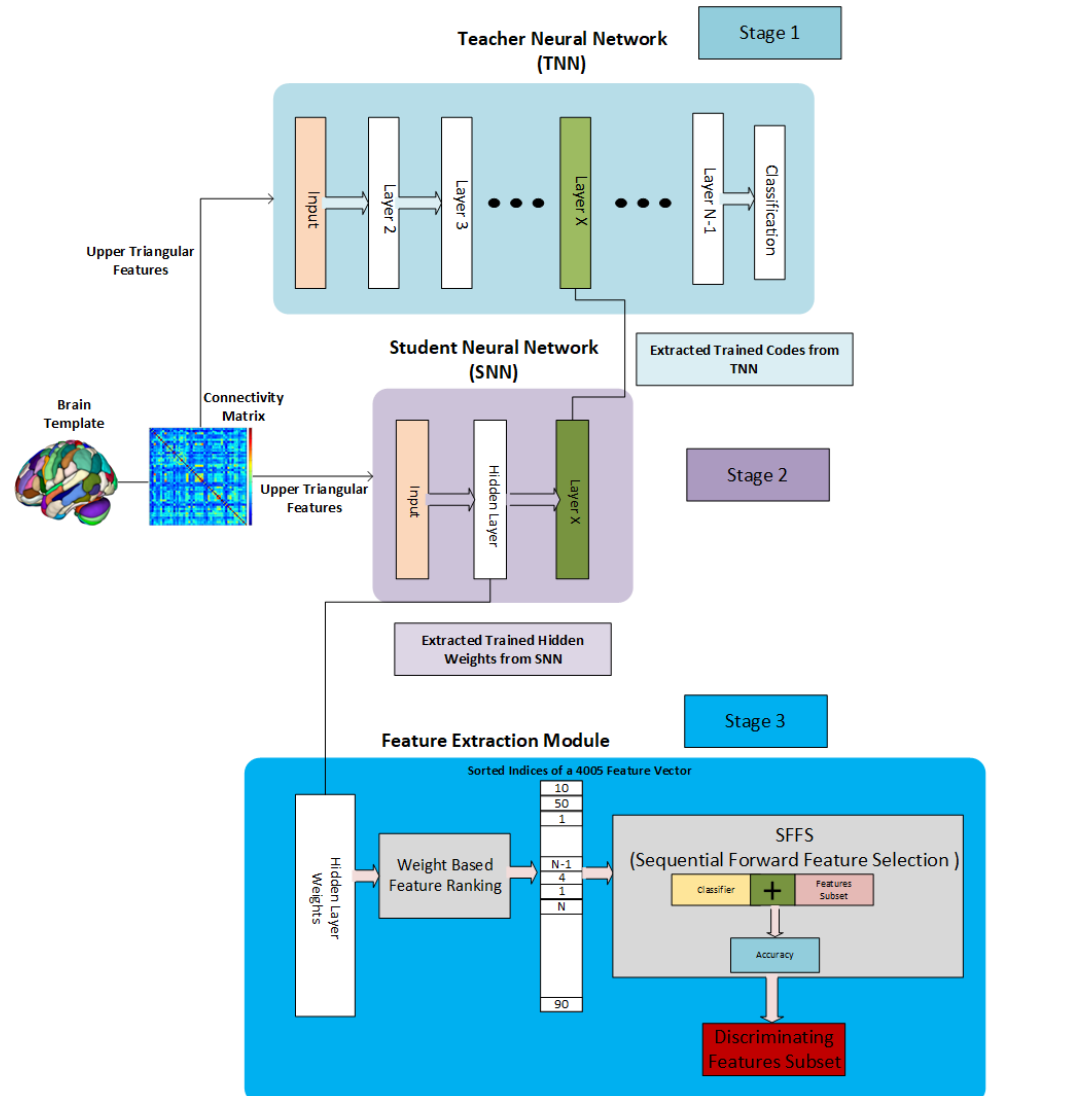
Figure 1. 3 Stage Teacher-Student-based and SFFS-based Feature Selection